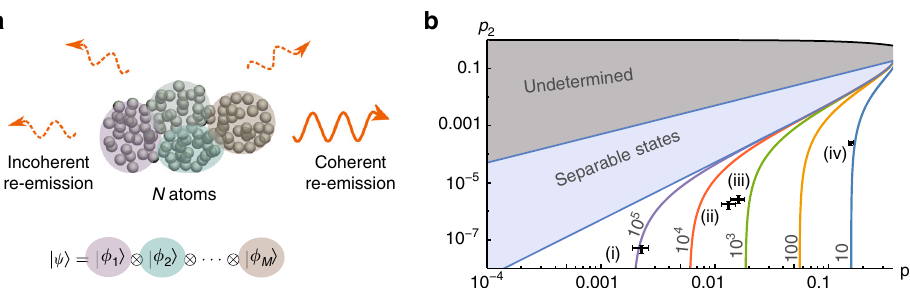
Fig. 2 Illustration of the basic ansatz and results of the entanglement witness. a The colored areas in the ensemble are genuinely entangled, while no entanglement is present between the groups. b The minimization of the two-excitation probability p 2 for given single-excitation probability p 1 and number of separable groups M leads to lower bounds which are independent of N if N (cid:5) 1. The central region in the plot is spanned by separable states (i.e., M = N ). Entanglement is required to reach smaller p p M that is compatible with 2 while keeping 1 constant. The number next to a colored line is the maximal data points on this line. This M is then used to bound the entanglement depth K = N / M . The four black crosses are data points from the experiment including one standard deviation, where different levels of inef fi ciencies are taken into account. Data point (i) is directly inferred from the raw data. Data point (ii) is obtained from (i) by removing the effect of fi nite detector ef fi ciencies. Data points (iii) and (iv) are more speculative as these points remove the effect of the re-emission ef fi ciency (for (iii) and (iv)) and the re-phasing ef fi ciency (for (iv)). A maximization of p 2 given p 1 and M would be necessary